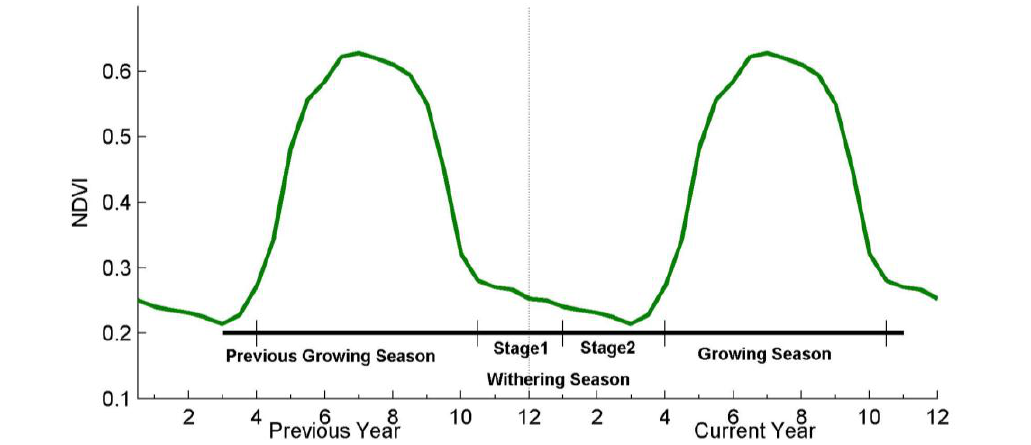
Figure 2. Periods of vegetation cycle (showed by NDVI variation of deciduous broadleaf forests in North